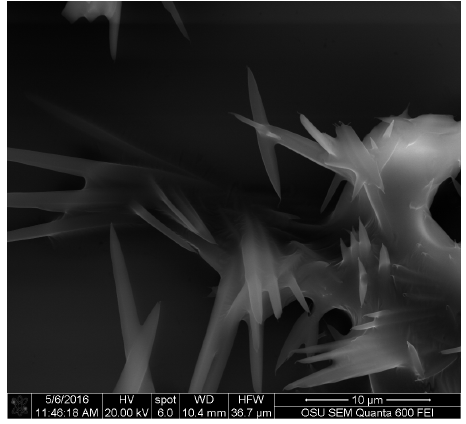
Figure 1. Crystalline structures from the pigment of Scytalidium cuboideum .